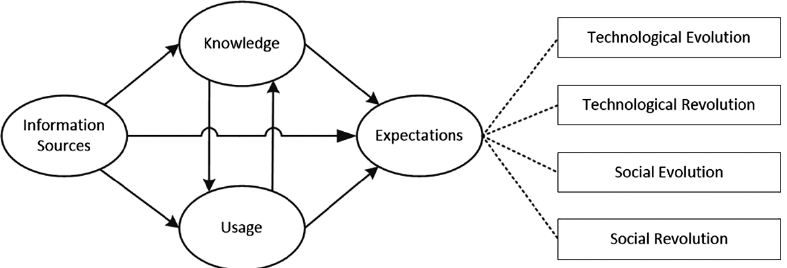
Figure 1. The Emerging Technologies Expectations Model